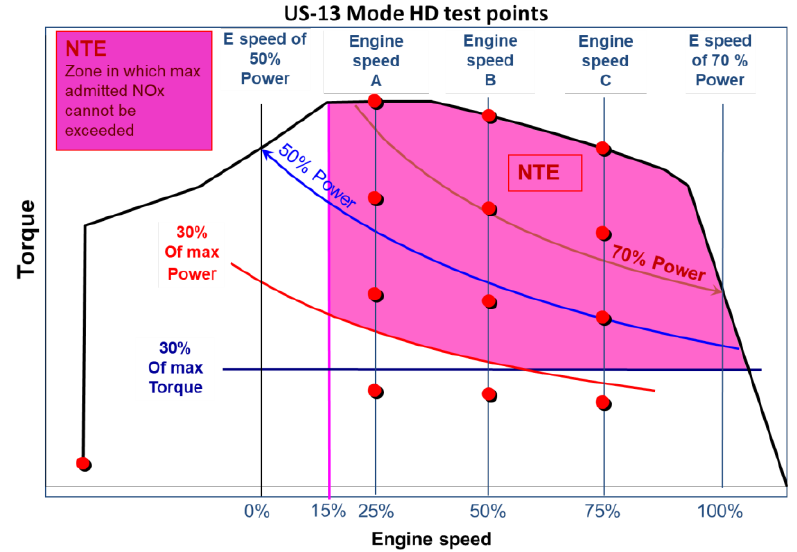
Figure 8. The testing cycle in 13 points (US-13 Mode HD test points).